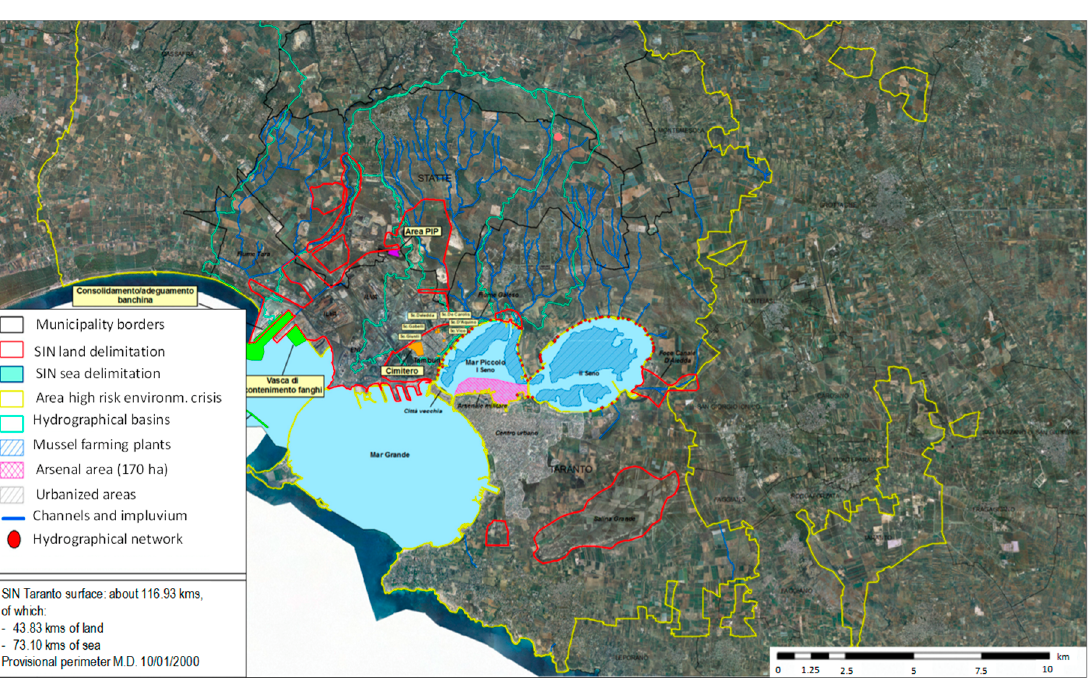
Figure 16. Localization of SIN Taranto (Ministerial Decree 10 January 2000).